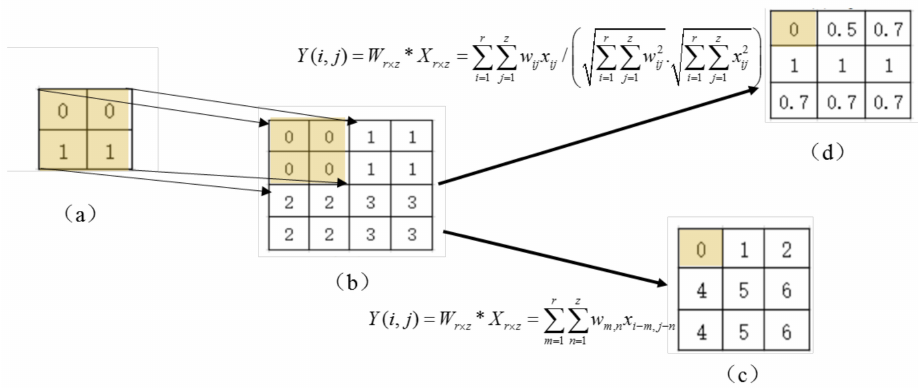
Figure 16. Comparison of two convolution operations. ( a ) Convolutional kernel; ( b ) Input feature map; ( c ) Traditional convolution output; ( d ) Convolution output based on cosine